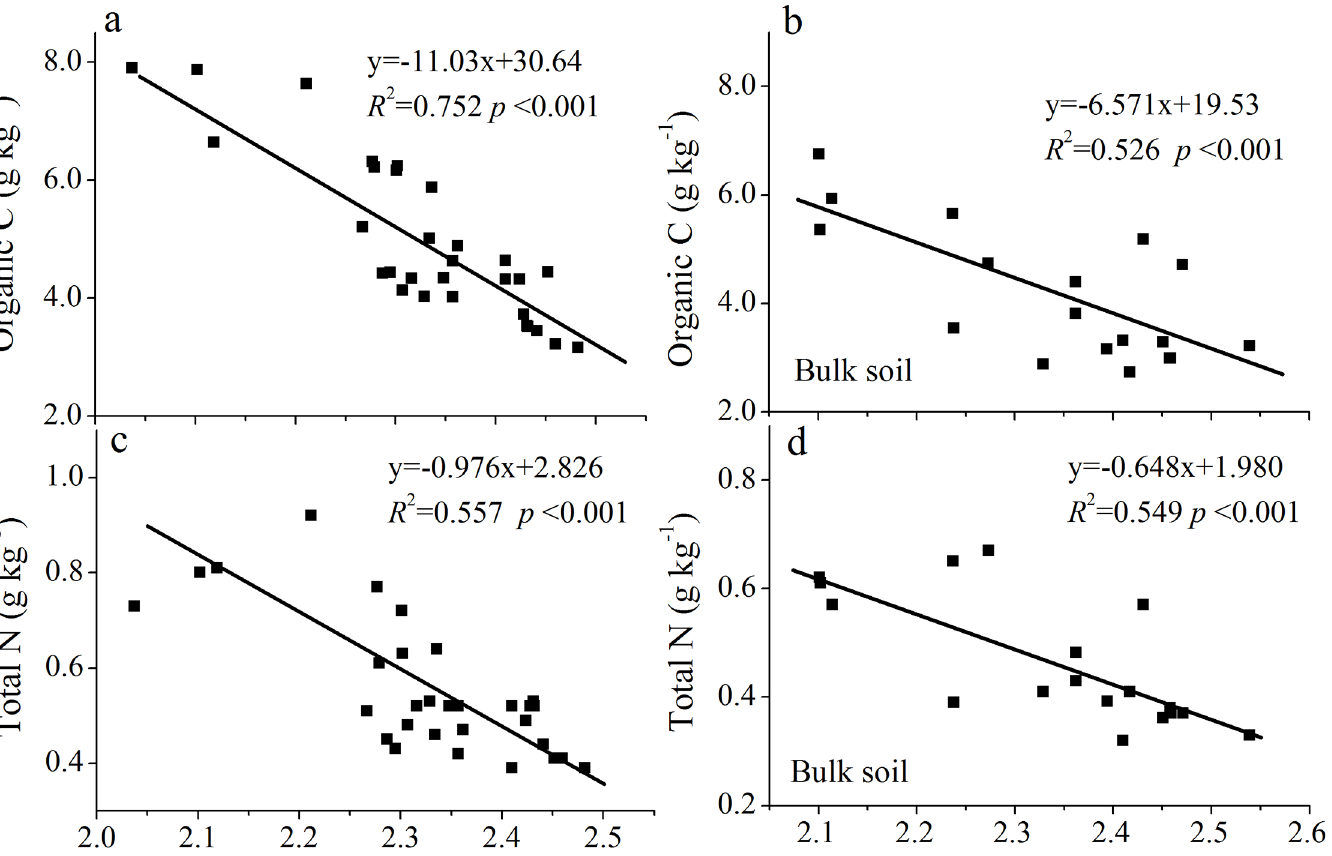
Fig 6. Relationships between fractal dimension, organic C and total N in the rhizosphere and bulk soils (a-d).